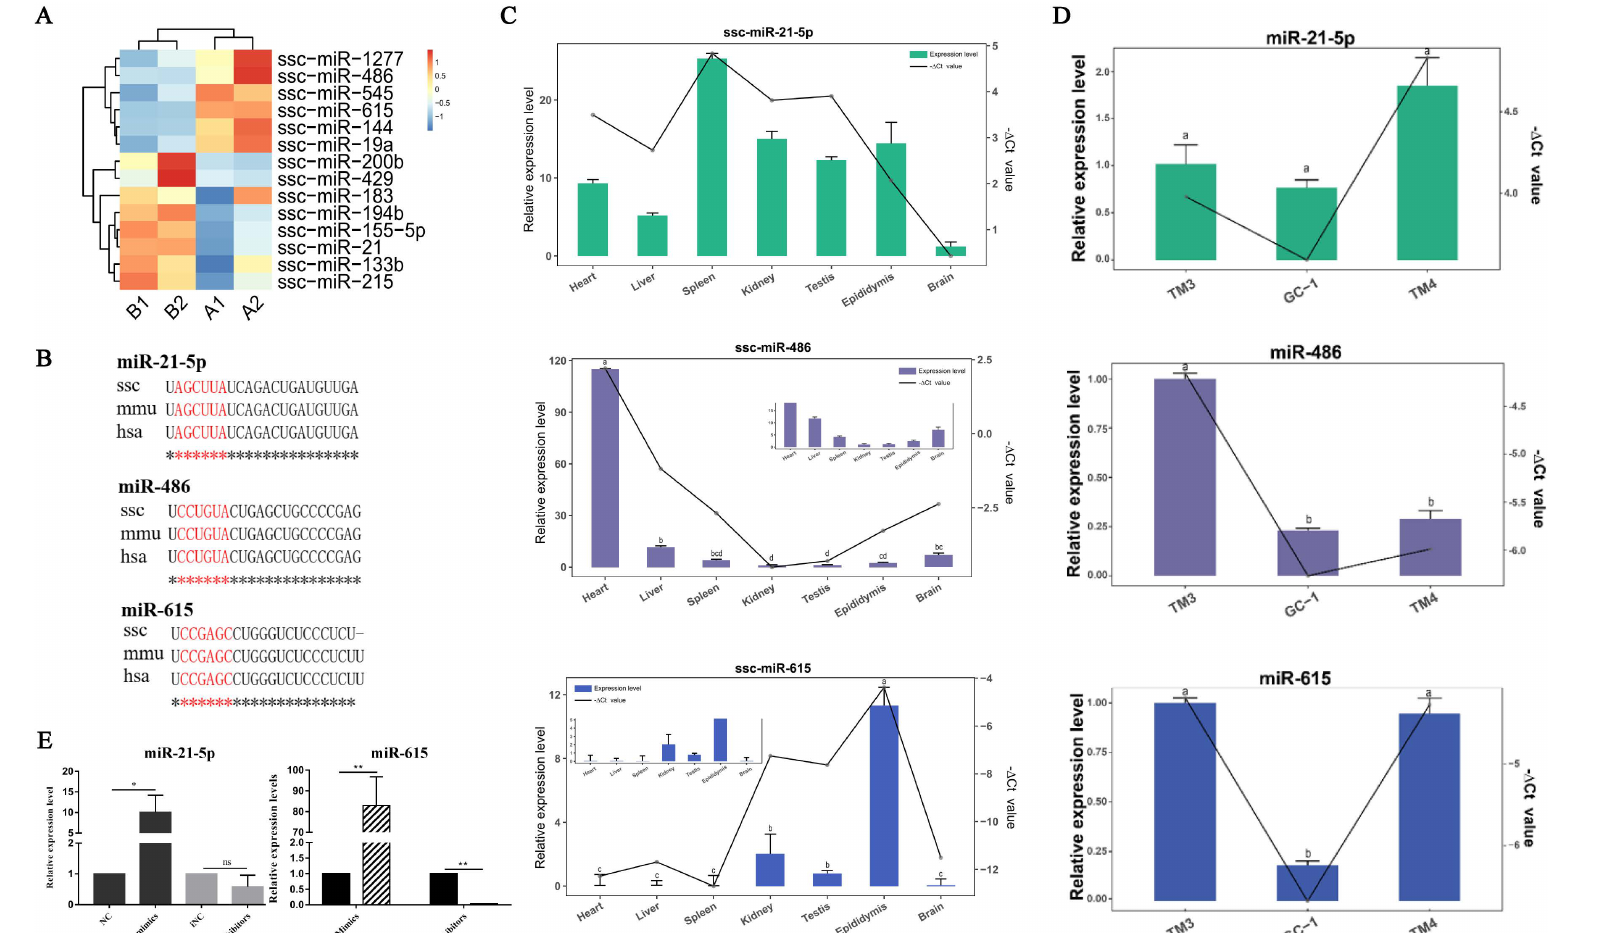
Figure 1. Preliminary screening and expression profile analysis of candidate miRNAs. ( A ) Cluster analysis between primary group (A1,A2) and EDS − treated group (B1,B2) [11]; ( B ) The alignment of three candidate miRNAs (miR-21-5p, miR-486 and miR-615) for pigs, mice, and humans. The red sequence represents the seed region; ( C ) Expression profiles of candidate miRNAs in different pig tissues; ( D ) Expression profiles of candidate miRNAs in mouse testis cells, including mouse Leydig cell line TM3, mouse Sertoli cell line TM4 and mouse germ cell line GC1 spg ; ( E ) miR-21-5p and miR-615 expression levels after overexpression or knockdown for 48 h. * Means p < 0.05, ** means p < 0.01. ns means no significant